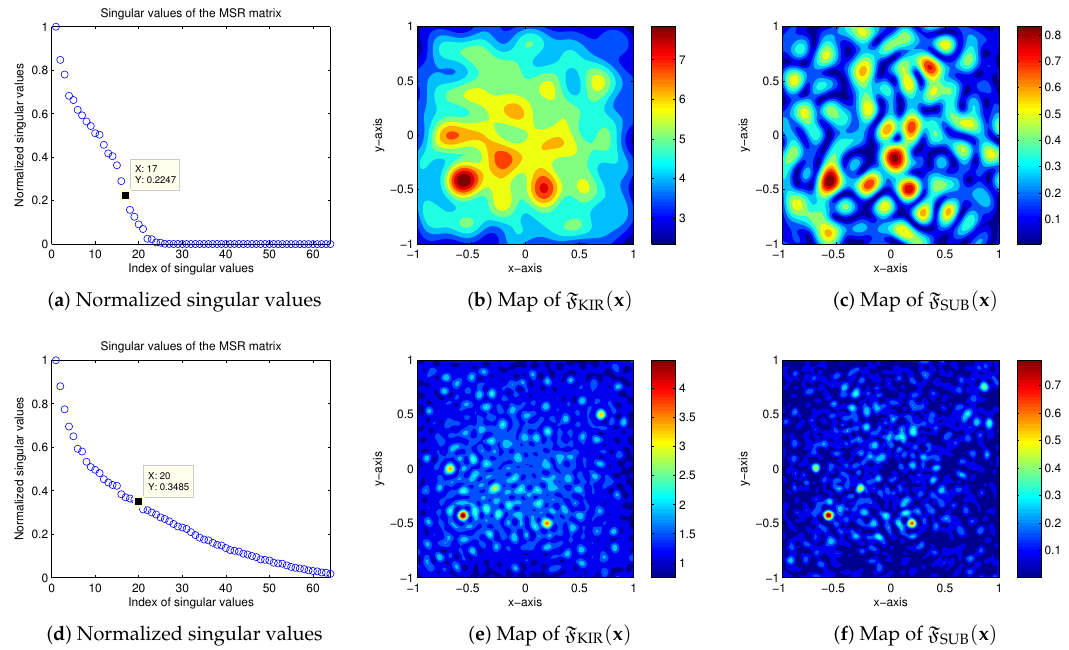
Figure 5. (Example 4: Case 3) Distribution of normalized singular values, maps of F KIR ( x ) and F SUB ( x ) for λ = 0.7 (top line) and λ = 0.2 (bottom